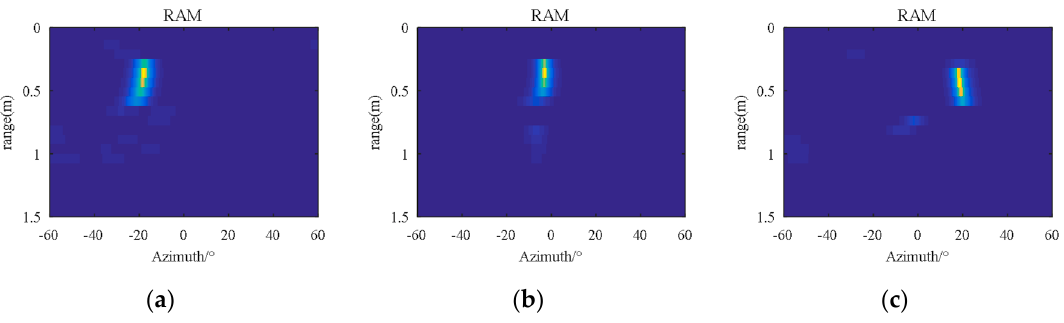
Figure 7. Range Azimuth Maps (RAMs) of target at different angular positions: ( a ) RAM of target at − 20°. ( b ) RAM of target at 0°. ( c ) RAM of target at 20°. Each frame signal can generate a RDM and a RAM with the above signal processing method.